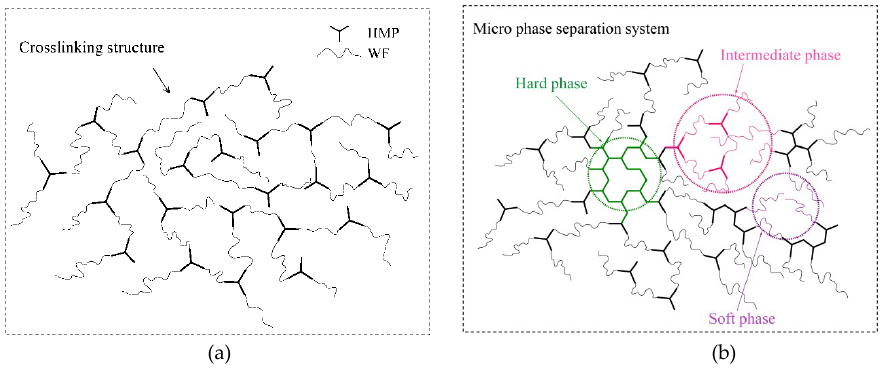
Figure 7. The crosslinking reaction of HMP / WF adhesives: ( a ) Crosslinking structure formed by WF and HMP, ( b ) Micro phase separation structure form by WF and